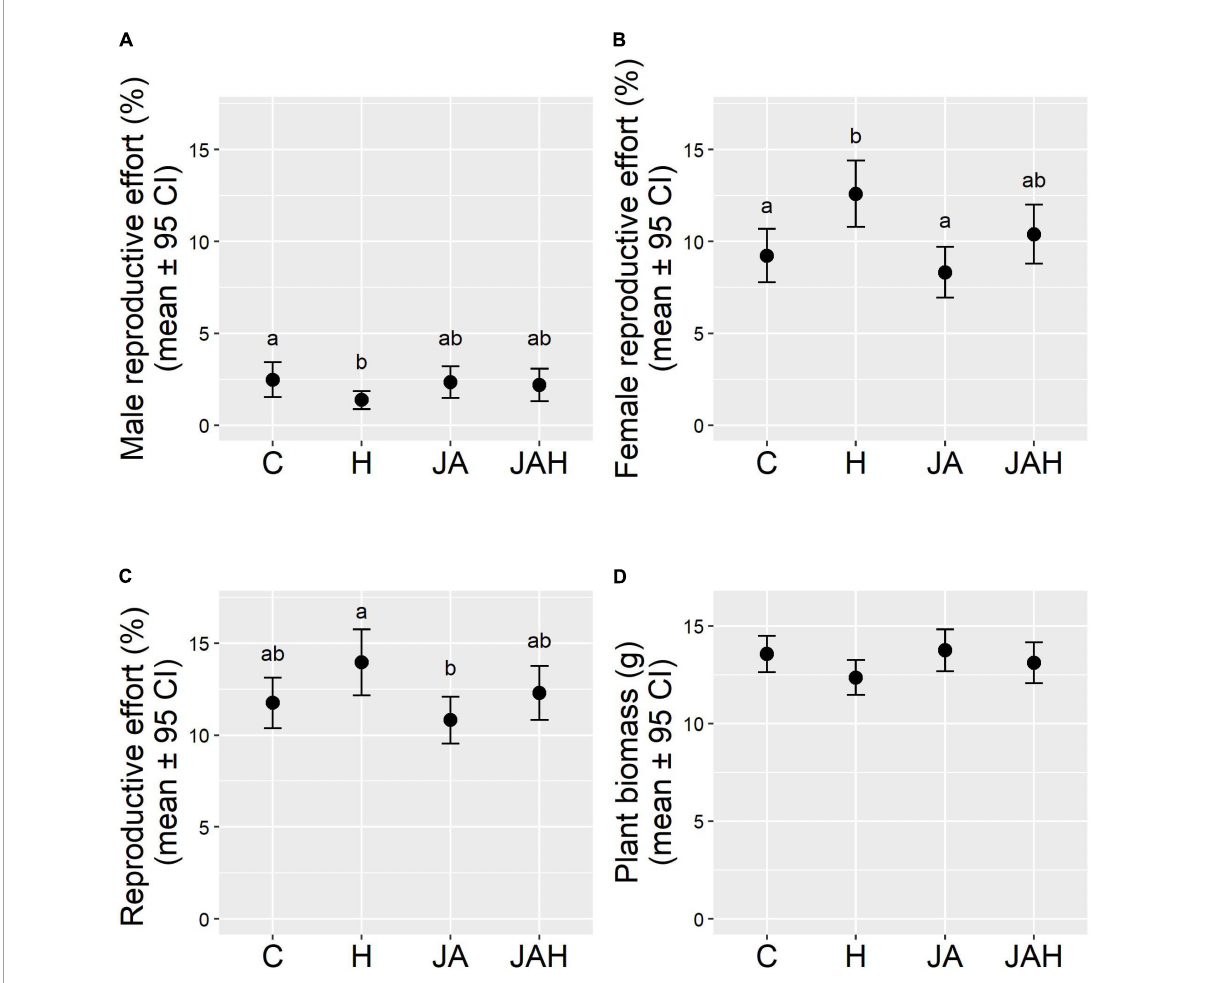
FIGURE1 Direct (tissue loss) and indirect (jasmonate-mediated) effects of herbivory on (A) male reproductive effort (male inflorescence biomass/vegetative biomass), (B) female reproductive function (seed biomass/vegetative biomass), (C) total reproductive effort (reproductive biomass/vegetative biomass), (D) total aboveground plant biomass. Note that variables in panels (A–C) were calculated on the basis of measurements of the apical subsample for each individual sampled. Treatments are abbreviated as follows, C, control; H, herbivory treatment with a chronic tissue loss of 25% of foliar area; JA, jasmonate application; JAH, tissue loss and jasmonate application treatment. Different letters indicate significant differences between treatment levels ( P < 0.05). Total N = 273